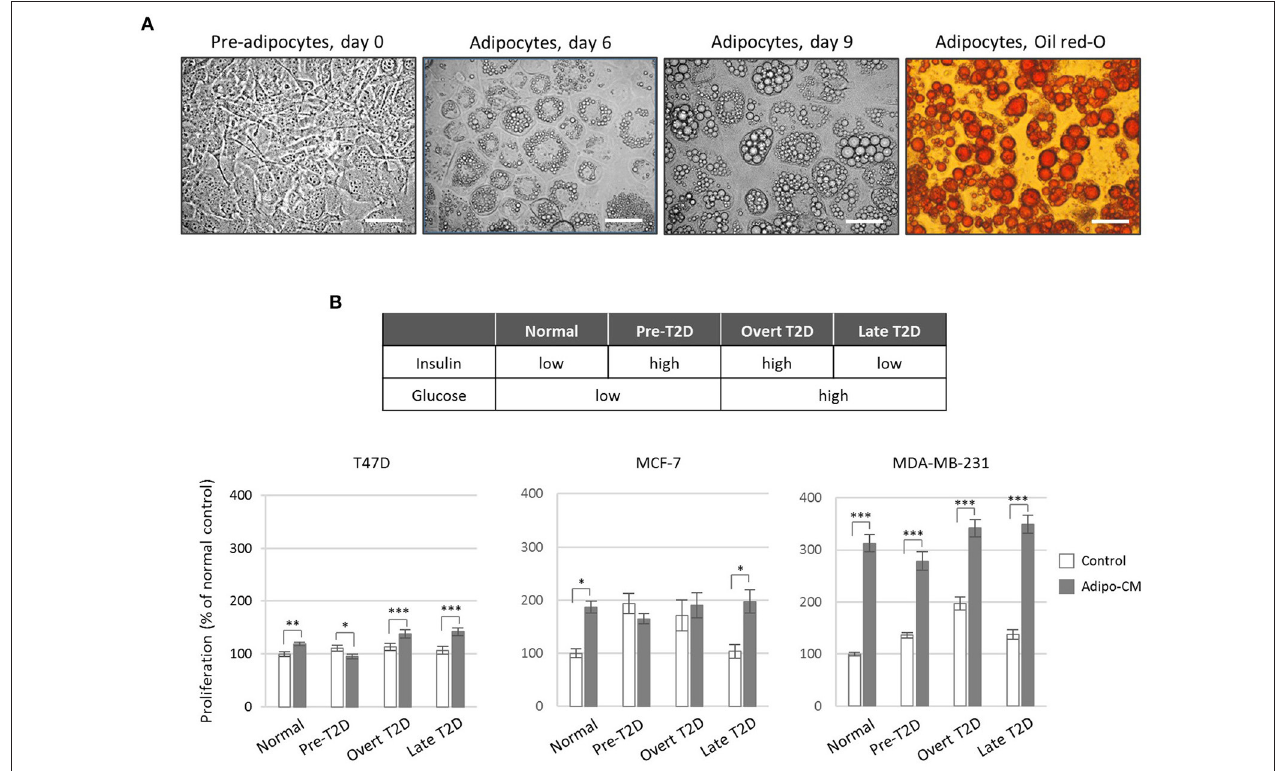
FIGURE 1 | Effect by the adipocyte secretome on proliferation of human breast cancer cells . (A) Photomicrograph images of in vitro cultured 3T3-L1 pre-adipocytes and differentiated adipocytes at x40 original magnification. Scale bars indicate 50 µ m. Adipocyte differentiation was validated by Oil-Red O staining. (B) Proliferation of human breast cancer cells in response to adipocyte-secreted factors. Human T47D, MCF-7 and MDA-MB-231 breast cancer cells were cultured in the presence of adipocyte conditioned media (gray bars) or control (white bars) under normal, pre-T2D, overt-T2D, or late-T2D conditions for 72h. Results are shown as percentage proliferation of normal control and represent mean ± SE of three independent experiments, each performed with five replicates. P -values are based on two-way ANOVA with Sidak’s multiple comparisons test. * P < 0.05, ** P < 0.01, *** P < 0.001.